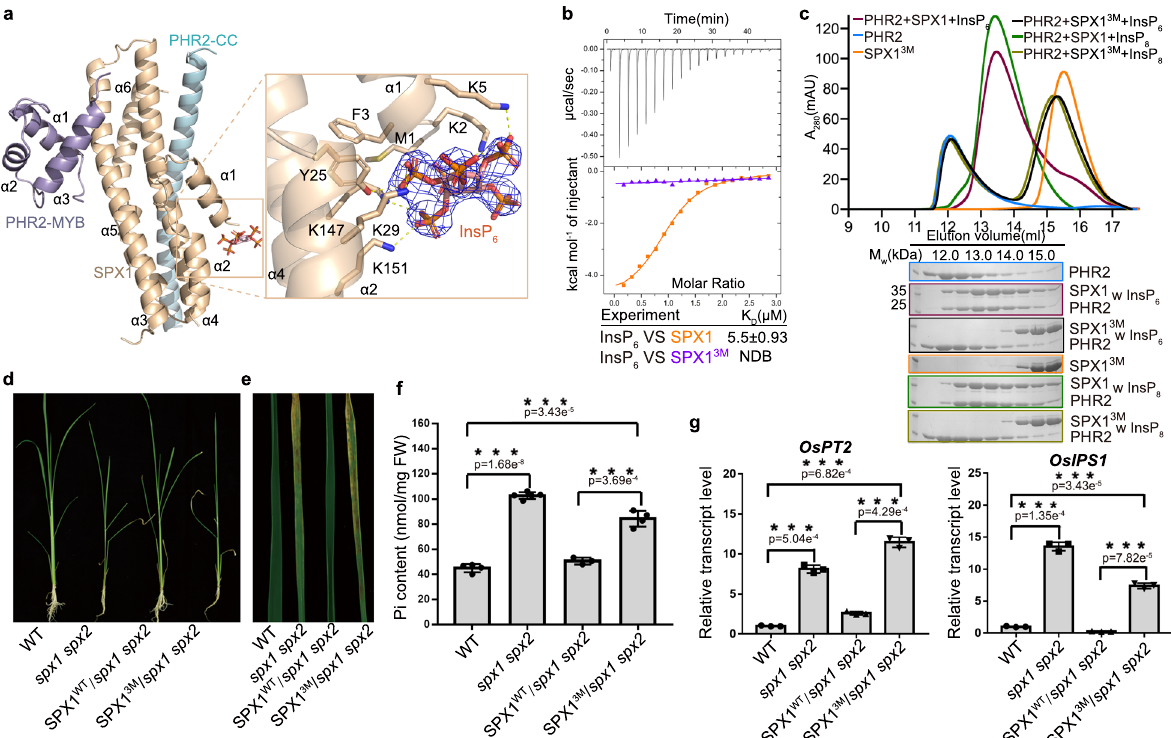
Fig. 3 Mutations in SPX1 InsP 6 -binding sites affect SPX1-PHR2 complex formation and Pi signaling. a A close-up view of the SPX1-InsP 6 interactions. InsP 6 was represented as a stick model with a stimulated annealing omit map and contoured at 1.1 σ . Residues of SPX1 interacting with InsP 6 were shown as sticks and labeled. The yellow dashed lines represent hydrogen bonds involved in the interaction of SPX1 and InsP 6 . b Binding af fi nities of InsP 6 with SPX1 1 – 259 (orange) and SPX1 1 – 259 Y25F/K29A/K151A (SPX1 3M , purple) were measured by ITC. NDB, no detectable binding. c Mutations of InsP 6 -binding sites in SPX1 1 – 259 impaired the SPX1 1 – 259 -PHR2 230 – 426 interaction. The assays were performed as described in (Fig. 1a). Experiments were independently repeated three times with similar results. Uncropped gel images are available as source data. d Growth phenotype of WT, spx1 spx2 , and two kinds of transgenic plants were grown under Pi-suf fi cient condition (SPX1 WT / spx1 spx2 and SPX1 Y25F/K29A/K151A / spx1 spx2 ). e Phenotype of phosphate excess in leaves of plants shown in ( d ). f Pi contents of plants shoots shown in ( d ). Error bars, mean ± s.d. The number of biologically independent samples of WT, spx1 spx2 , SPX1 WT / spx1 spx2 and SPX1 3M / spx1 spx2 is 4, 5, 3 and 4, respectively. Sets of data were analyzed by independent-samples T test (two-tailed), where *** represents a statistically signi fi cant difference at p < 0.001. g PSI genes ( OsIPS1 and OsPT2 ) expression in the root of the plants shown in ( d ). Error bars, mean ± s.d. The bar graphs show the results from three biologically independent samples ( n = 3). Sets of data were compared by paired- samples T-test (two-tailed), where *** represents a statistically signi fi cant difference at p <